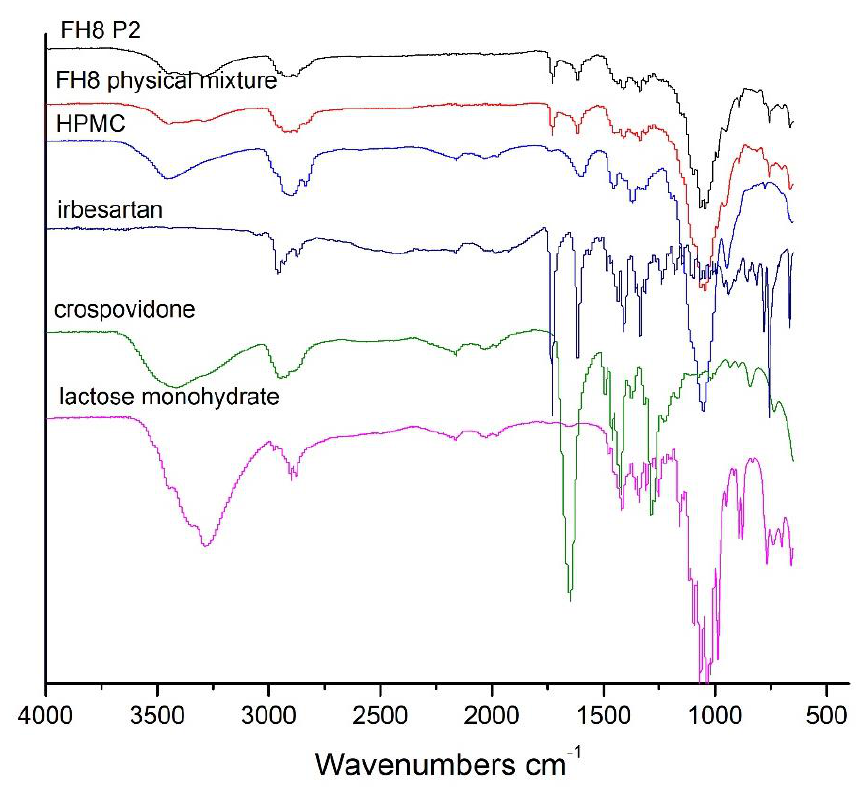
Figure 7. FT-IR spectra of raw materials and evaluated tablet formulations.